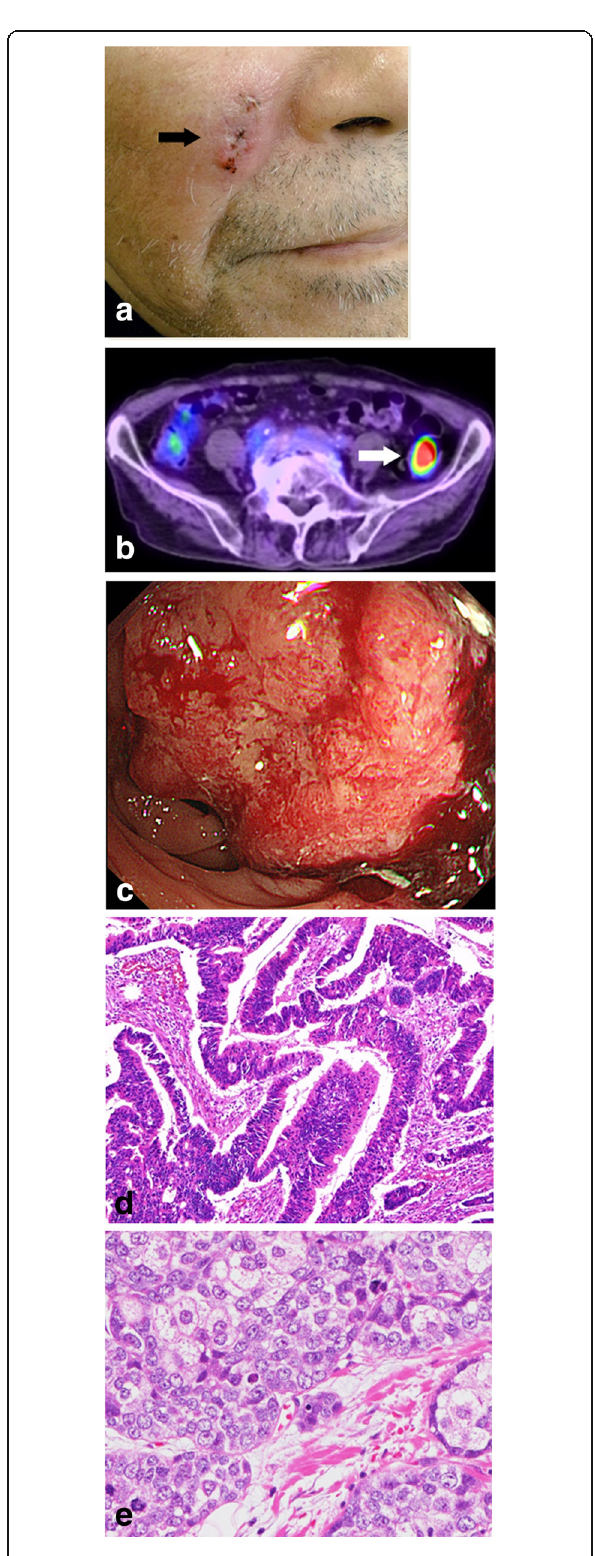
Fig. 2 Clinicopathological findings of case 2. a Continuous papules measuring 15×11 mm with telangiectasia were present on the right side of the cheek ( black arrow ). b Positron emission tomography/ computed tomography showed intense tracer uptake (maximum standardized uptake value = 36.8) at the sigmoid colon ( white arrow ). c Colonoscopy showed an ulcerated hemorrhagic type 2 tumor at the sigmoid colon. d Pathological examination of the sigmoid colon tumor revealed heterogeneity of well-differentiated adenocarcinoma, moderately differentiated adenocarcinoma, and mucinous adenocarcinoma (hematoxylin and eosin stain (H.E.), ×100). e Pathological examination of the tumor on the right cheek